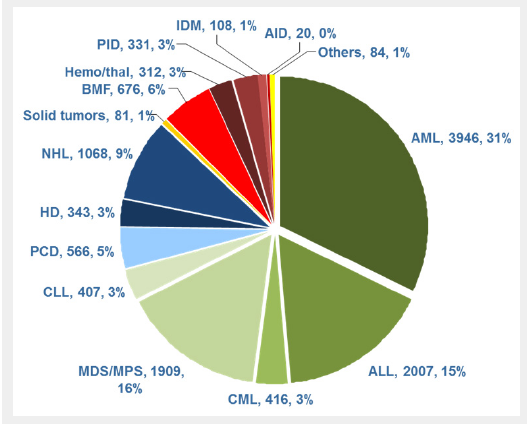
Figure 2A Indications for allogeneic HSCT in Europe in 2010 (reprinted from: Passweg JR, Baldomero H, Gratwohl A, Bregni M, Cesaro S, Dreger P, et al.; for the European Group for Blood and Marrow Transplantation (EBMT). The EBMT activity survey: 1990–2010. Bone Marrow Transplant. 2012;47(7):906-23 [3]). Abbr: AML Acute Myeloid Leukaemia, ALL Acute Lymphoblastic